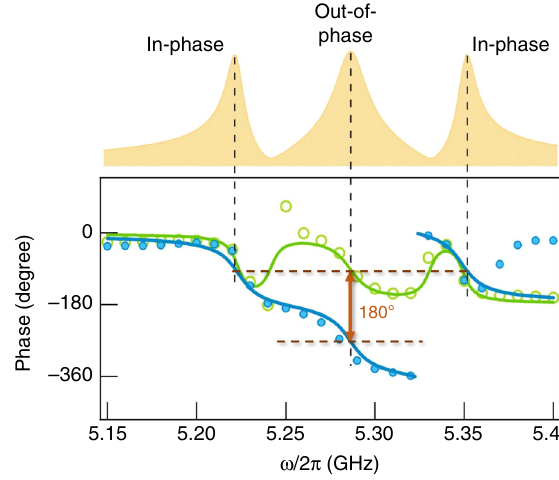
Fig. 3 Phase of X-CMP dynamics. The measured phases of X-CMP dynamics in ~ V x and ~ V y have been plotted, displayed in green circles and blue circles, respectively. Here the phase in y -direction has been wrapped. By using the Hall-like transport model, these phases can be well explained. We show the calculated phases for both x - and y -directions with green solid line and blue solid line, respectively. A schematic X-CMP pro fi le has been plotted above the fi gure to show the three non-degenerate polariton modes. We demonstrate that the two side modes are in-phase while the central mode shows out-of-phase